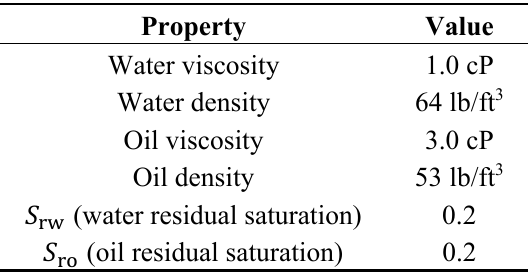
Figure 16. ( a ) Relative permeability and ( b ) capillary pressure of case 3. Table 6. Case 3 fluid properties.